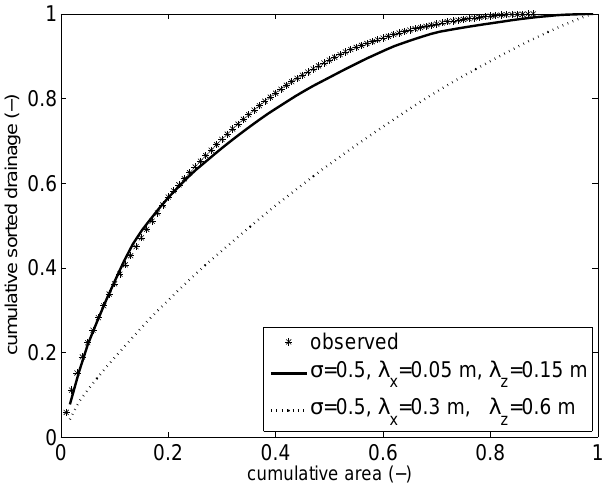
Fig. 6. Sorted observed drainage, and simulated with two standard deviations and correlation lengths for generated random fields with Miller–similarity.